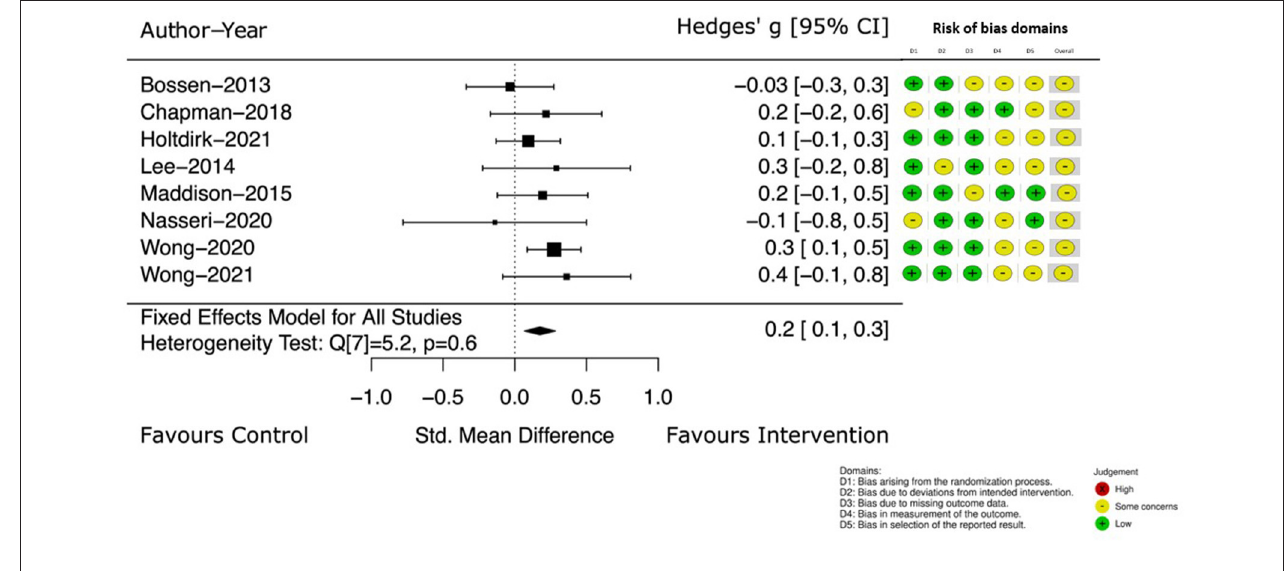
FIGURE 3 | Self-reported PA at end of intervention.